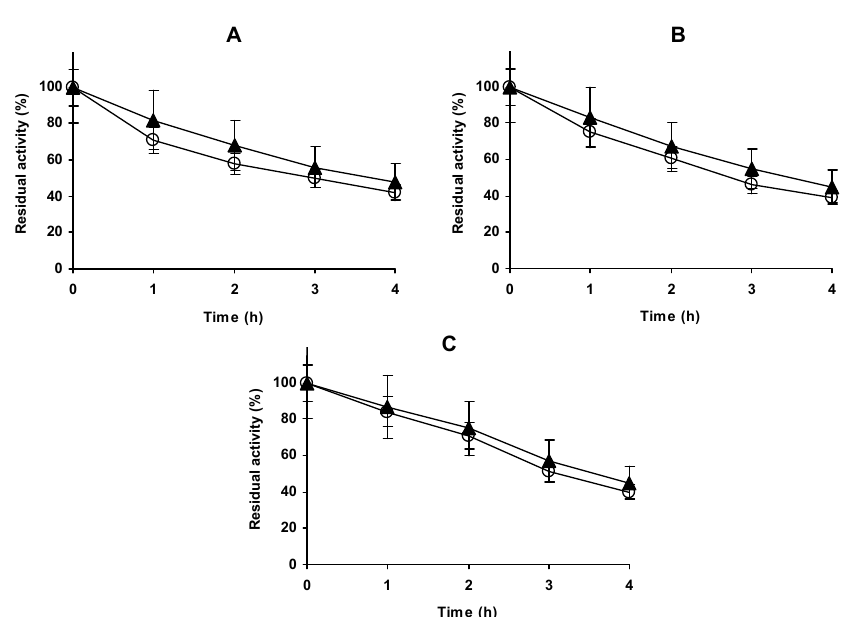
Figure 4. Effect of the amination on the stability of Glx-AL at pH 4 (44 °C) ( A ) 7 (54 °C), ( B ) or 9 (58 °C) ( C ) Other specifications are described in Methods section. Glx-AL: open circles; Glx-AL-EDA: solid triangles .